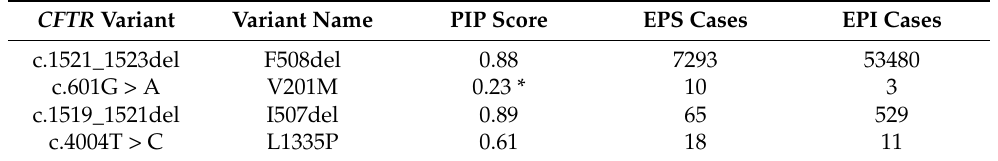
Table 3. Pancreatic insufficiency prevalence (PIP) score calculated on CFTR mutations present two or more times in our Puerto Rican pediatric cohort using the CFTR2 database to